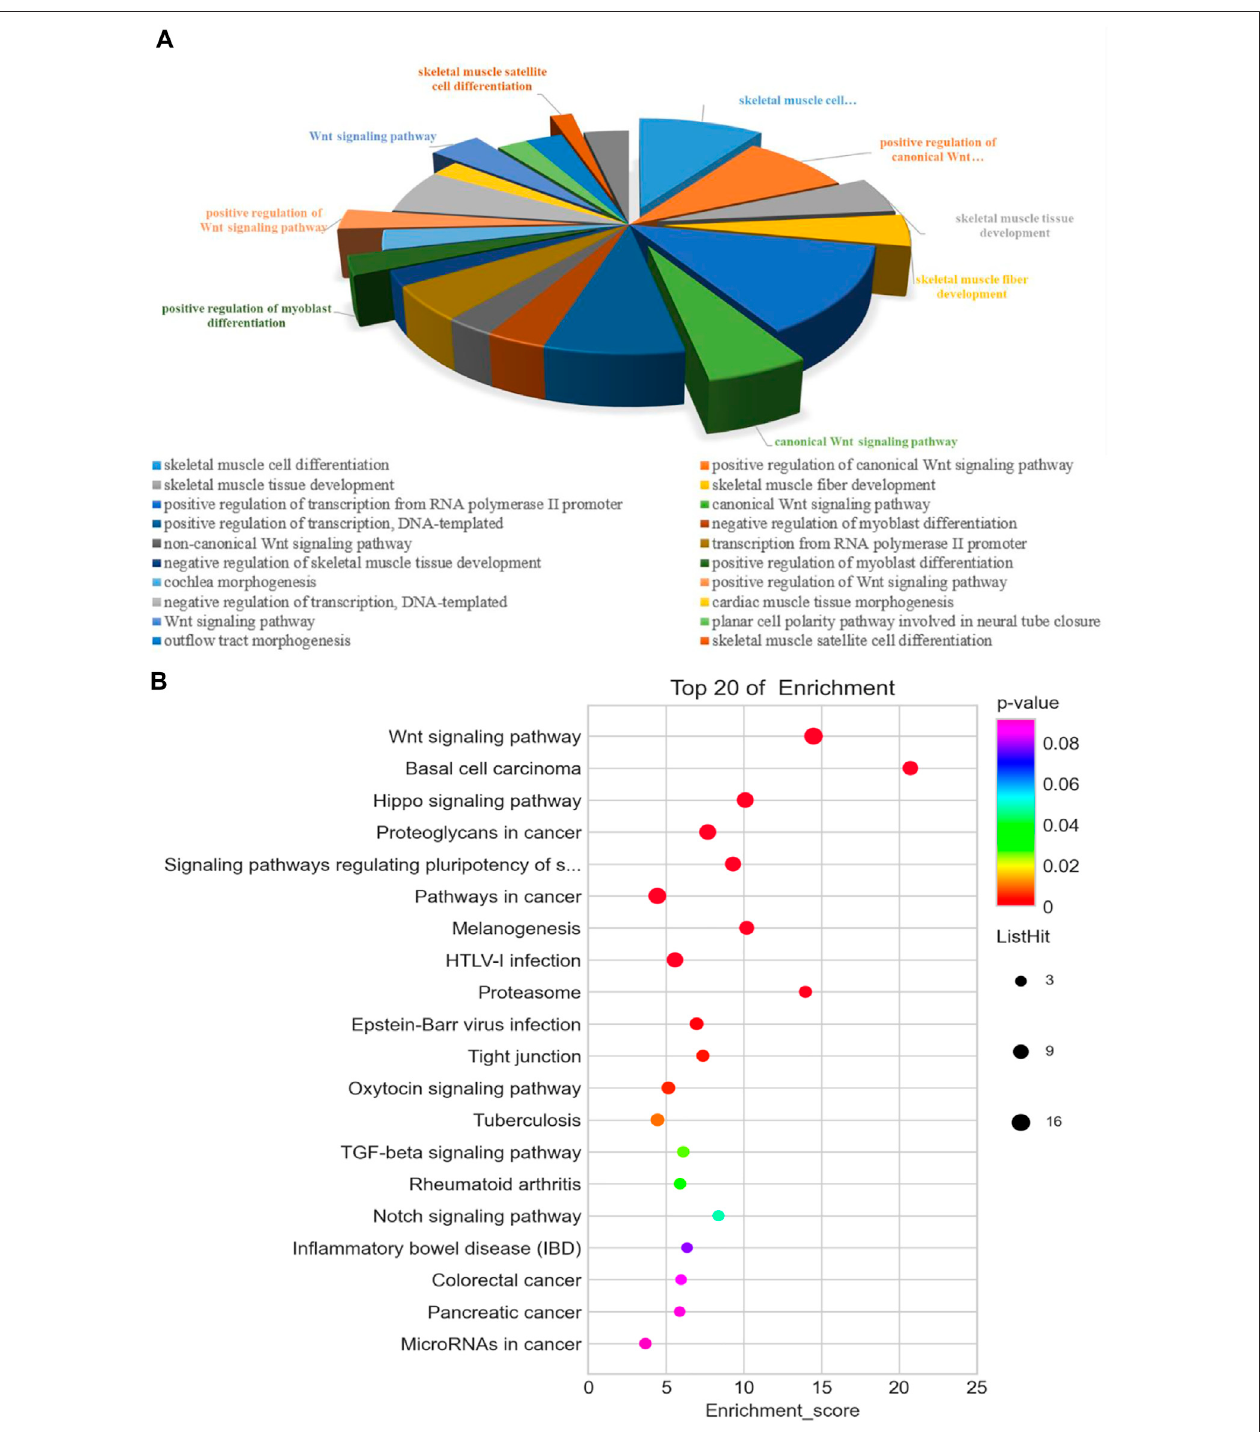
FIGURE4| Functionalanalysisof117differentiallyexpressedgenesassociatedwithmuscledevelopmentandfatnessbetweenthecattle-yakandyak.GO (A) and KEGG (B)